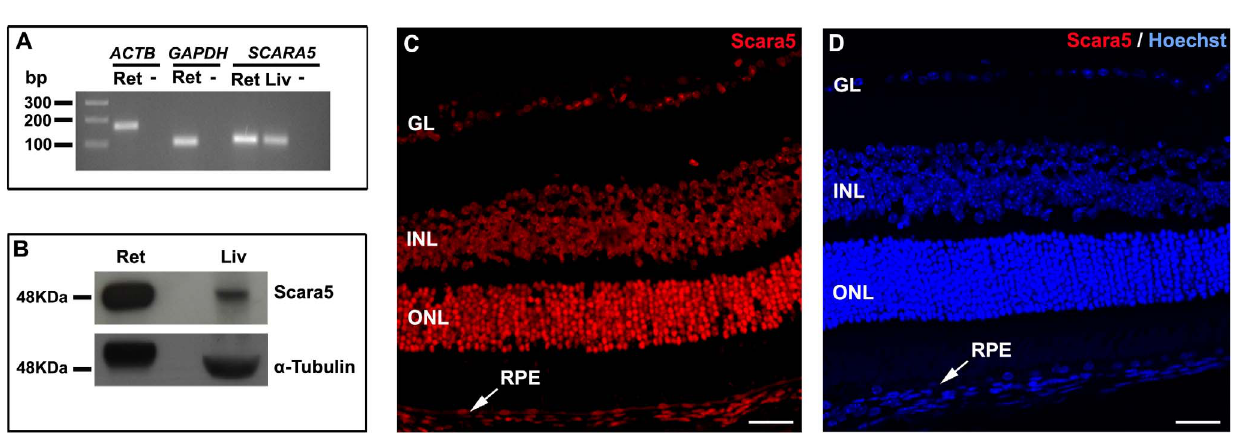
Figure 1. Scara5 was expressed in mouse retinal cells. A: The expression of SCARA5 mRNA in the retina was evaluated by q-RT-PCR. Agarose gel electrophoresis of q-RT-PCR products confirmed that SCARA5 single amplicon with 108 bp was generated. ACTB and GAPDH were used as housekeeping genes. B: Western blotting analysis revealed a specific band with a molecular weight of 48 KDa, confirming the presence of Scara5 receptors in the retina. a -tubulin was used as a loading control. C: Retinal immunolabeling with a specific antibody in a histological section, along the eye axis through the optic disc and cornea, showed that Scara5 was expressed throughout the retina, mainly at the level of ganglion cell layer, inner nuclear layer, outer nuclear layer and RPE. D: Immunohistochemical negative control, where the primary antibody was omitted. Ret, retina; Liv, liver; -, no-template control; GL, ganglion cell layer; INL, inner nuclear layer; ONL, outer nuclear layer; RPE, retinal pigment epithelium. Scale bars: 28 m m (A); 28 m m